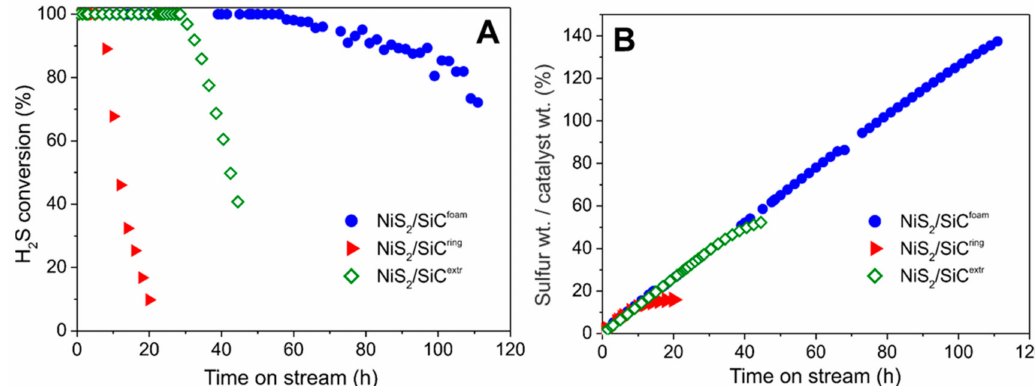
Figure 3. ( A ) H 2 S conversion on various NiS 2 /SiC x catalysts (x = foam, extrudates, rings); ( B ) Solid sulfur deposited on the catalyst expressed as wt.% increase of the spent catalyst with respect to the initial catalyst weight. Reaction conditions: [H 2 S] = 0.5 vol.%, [O 2 ] = 1.25 vol.%, O 2 -to-H 2 S ratio = 2.5, [H 2 O] = 30 vol.%, balance helium, reaction temperature = 60 ◦ C, GHSV (STP) = 1200 h − 1